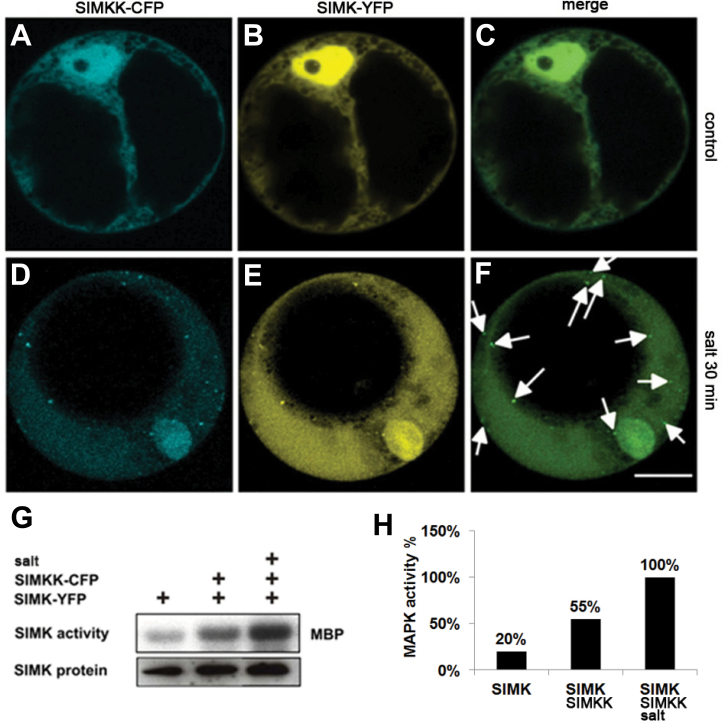
Co-localization of SIMKK and SIMK in Arabidopsis protoplasts. (A–C) Co-localization of CFP-tagged SIMKK (A) and YFP-tagged SIMK (B) in transiently co-transformed Arabidopsis protoplasts. In control protoplasts, both SIMKK (A) and SIMK (B) were predominantly nuclear proteins (merged image shown in C). (D–F) After salt treatment (250mM NaCl for 30min), both SIMKK (D) and SIMK (E) relocated to the cytoplasm where they co-localized on cytoplasmic punctate compartments (merged image shown in F, indicated by arrows). (G) Immunokinase assays and immunoblots showing SIMK activity (upper panel) and protein levels (lower panel) of SIMK in control and salt-treated (250mM NaCl for 30min) protoplasts co-transformed with SIMKK–CFP and SIMK–YFP. (H) Maximal activity of SIMK in salt-treated cells co-transformed with SIMKK. Bar, 10 μm (A–F).